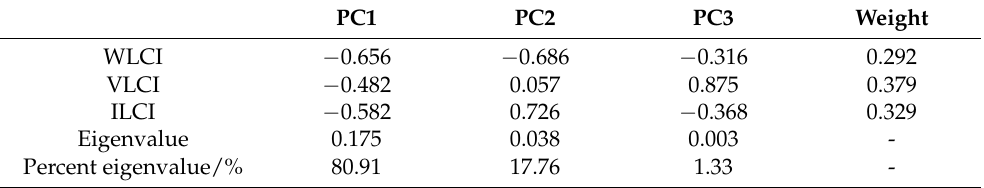
Table 4. Principal component analysis of the overall landscape pattern comprehensive